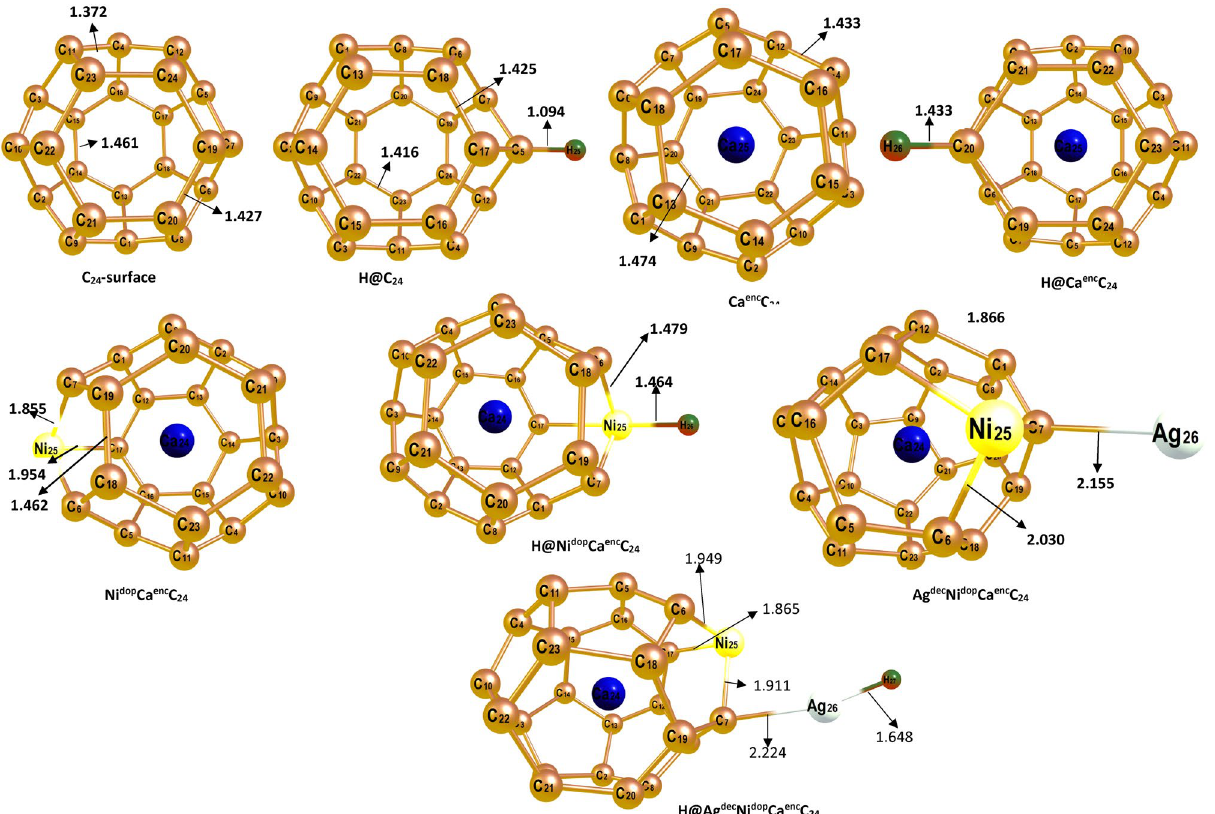
Figure 1. Optimized geometry of the bare C 24 surface, and engineered C 24